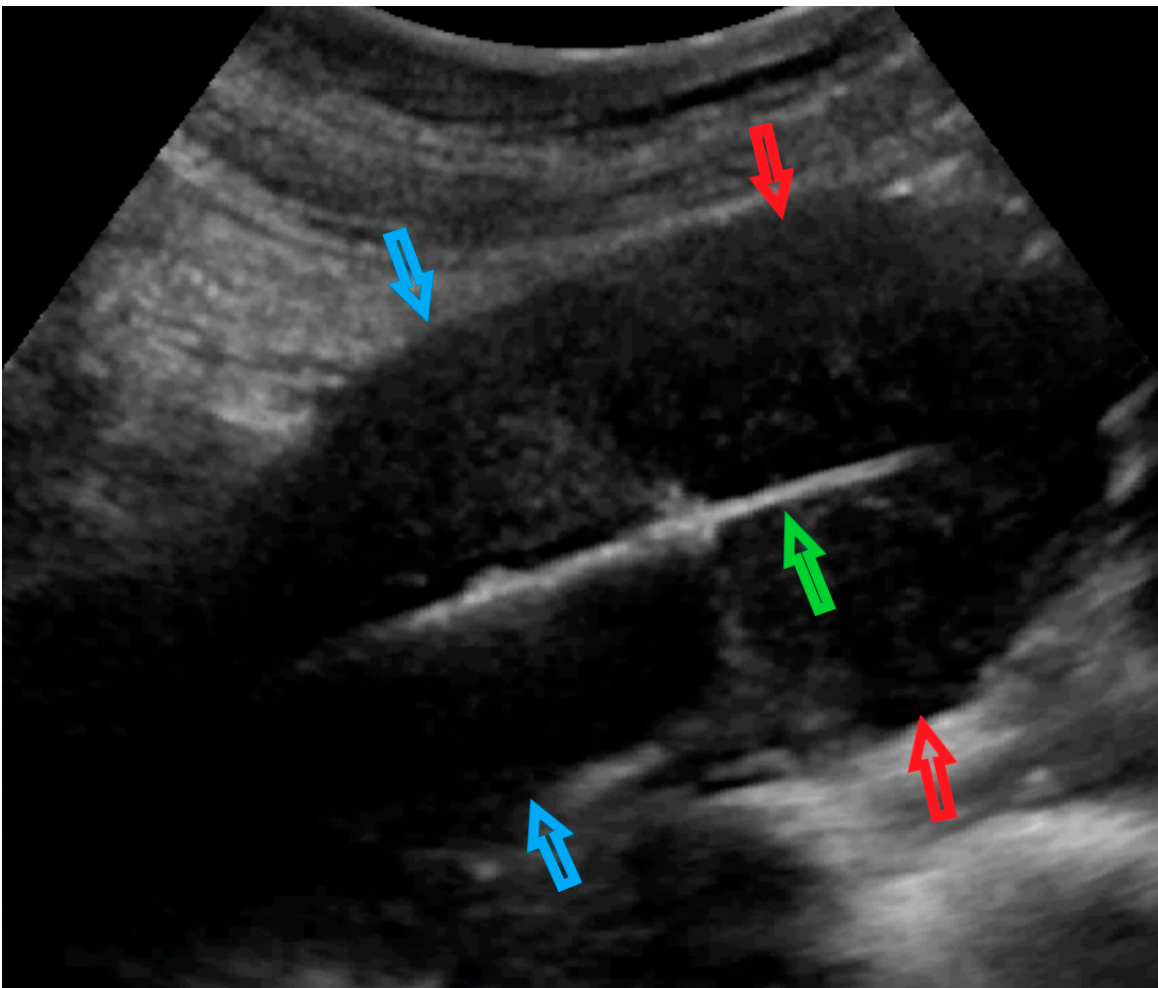
Figure 3. Transabdominal ultrasonogram of the uterus and core needle biopsy of the uterine lesion. The red arrows indicate the uterine lesion (in the uterine doom myometrium); blue arrows indicate the uterine corpus; the green arrow indicates the automatic biopsy system in the uterine cavity. The core needle is activated into the uterine myometrium lesion.